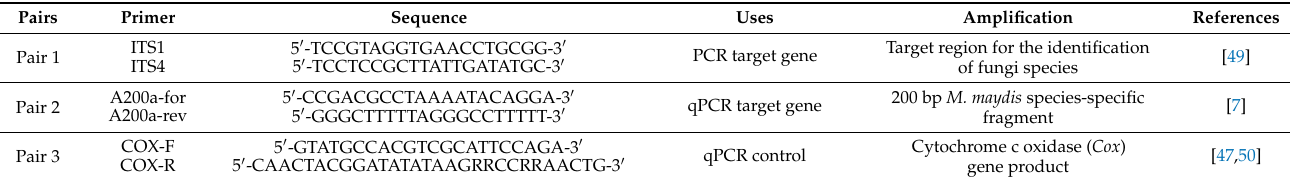
Table 2. Primers used in this